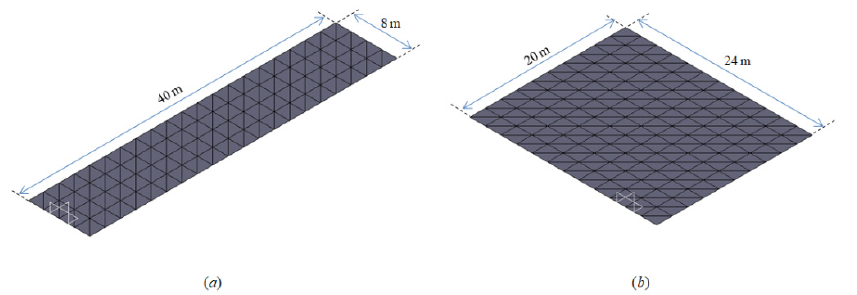
Figure 31. Geometry of developed three-dimensional ground: ( a ) geometry of ground for straight driving, ( b ) geometry of ground for steering driving.